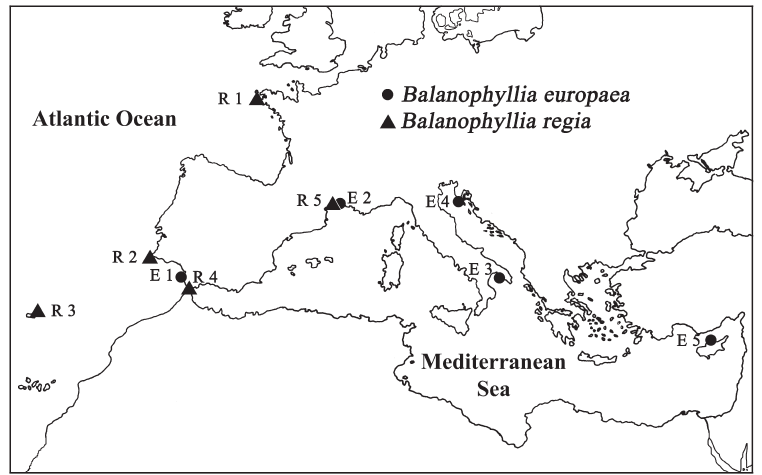
F IG . 2. – Map indicating the sampling stations of Balanophyllia europaea (E1 to E5) and Balanophyllia regia (R1 to R5), see Table 1 for more details.